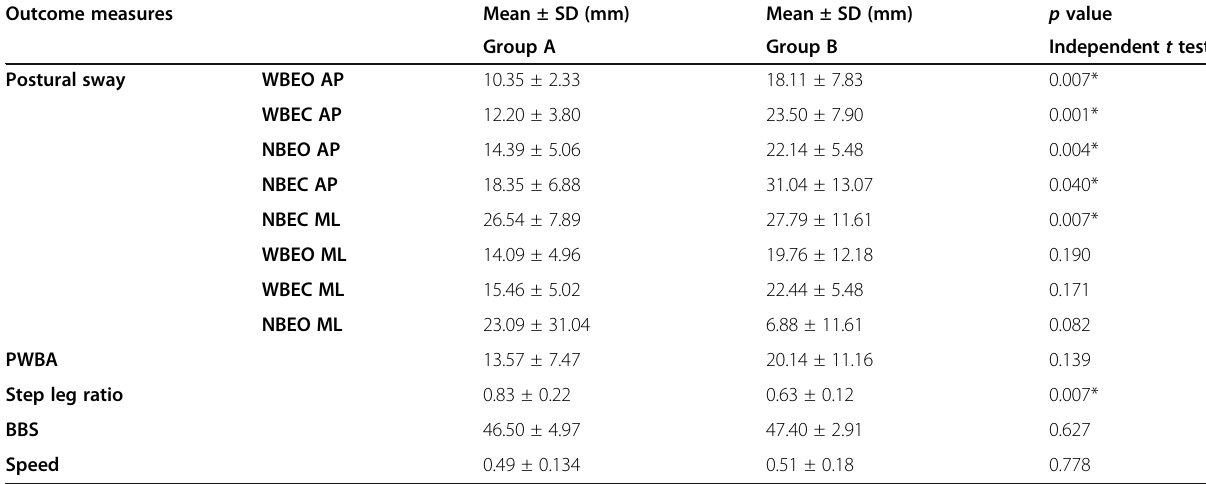
Table 2 Intergroup Comparison of Balance and gait parameters Outcome measures